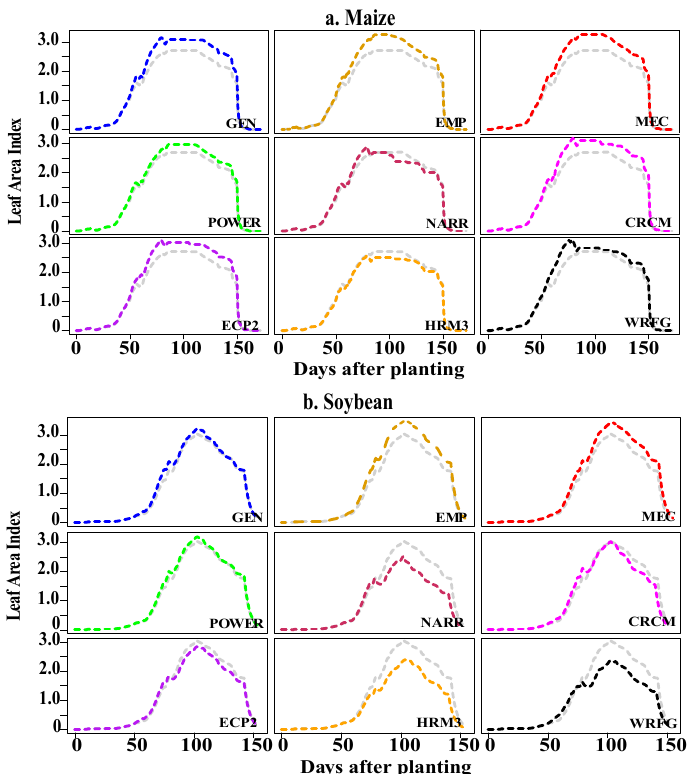
Figure 6. Root mean squared error (RMSE, colored circles) and mean error (ME, colored bars) of daily leaf area index (LAID) for the different sources of estimated solar radiation at the start date of planting, emergence, anthesis, and maturity for maize ( a ) and soybean ( b ). See Figure 2 for defi- nition of abbreviations.